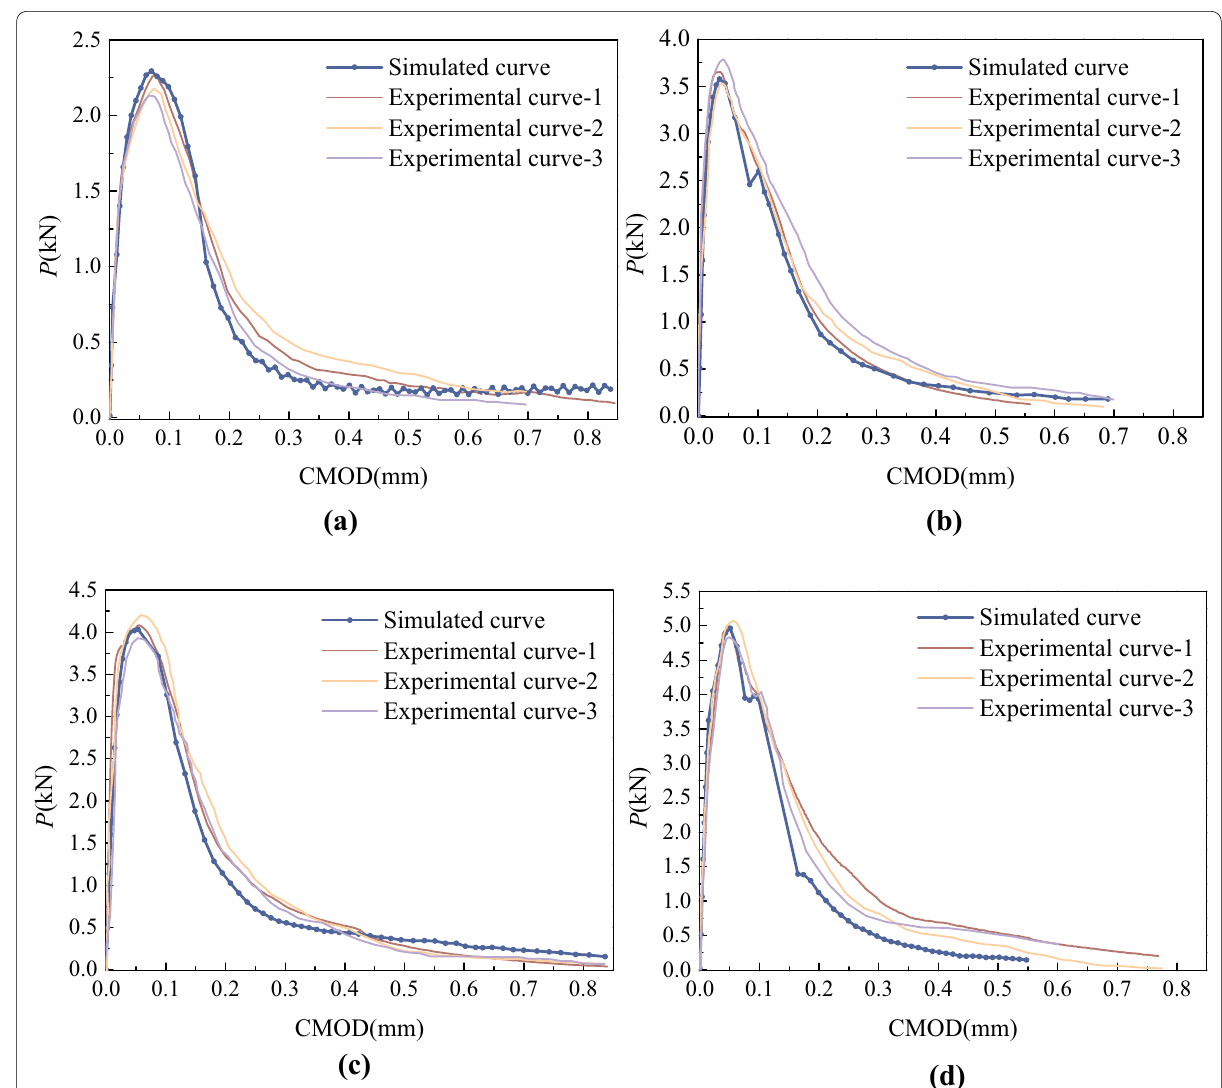
Fig. 18 P ‑CMOD curves of double‑crack specimens with ( a ) θ simulations at the loading rate of 1